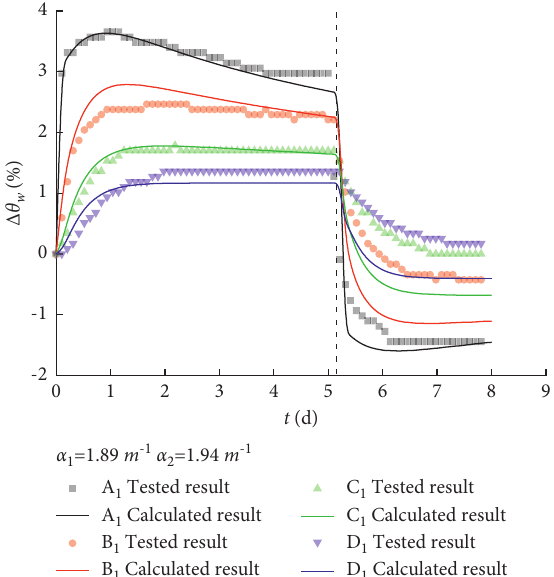
Figure 6: Comparison of results of the volumetric water content with numerical calculation in case 2.